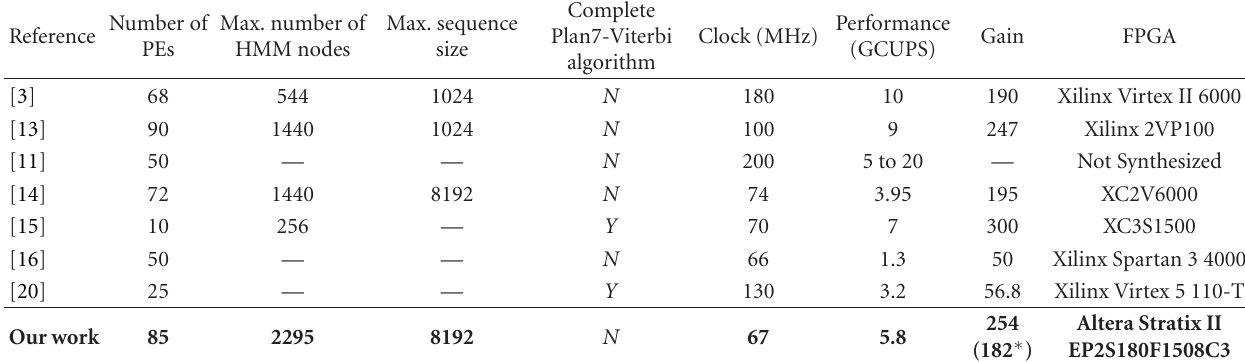
Table 8: Related work and comparison with our